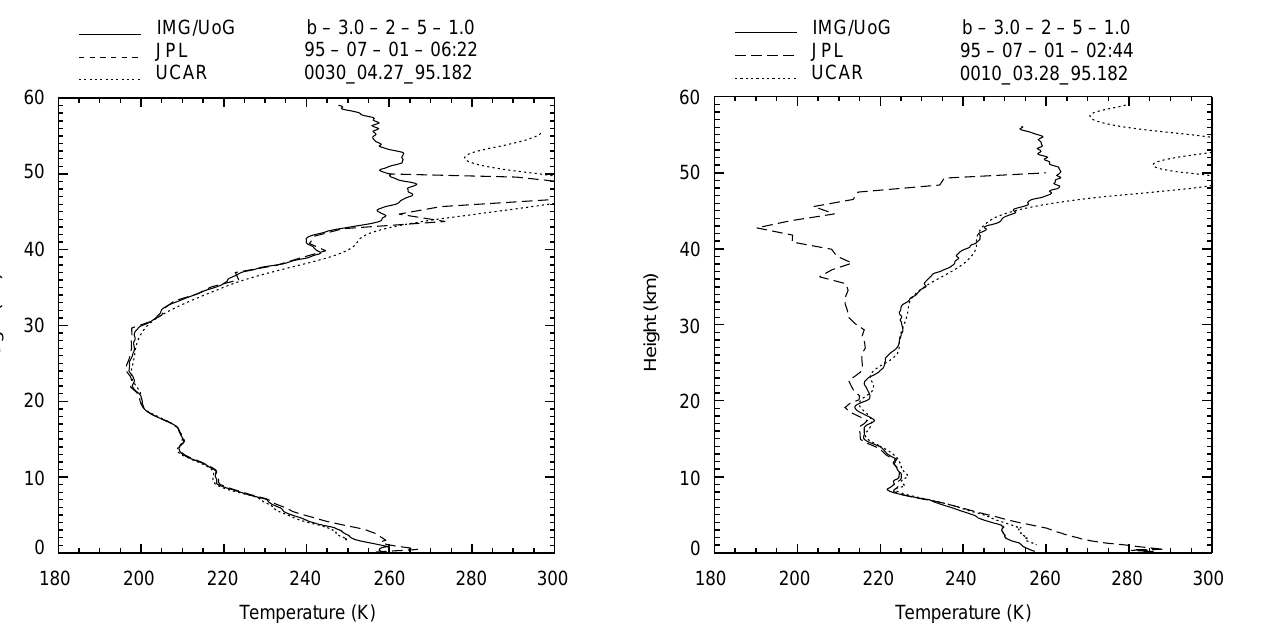
Fig. 8. Same as Fig. 6. This is an example for extreme disagreement between the three temperature retrievals. The occultation event took place at 37 (cid:14) S, 156 (cid:14) E on 1 July 1995,